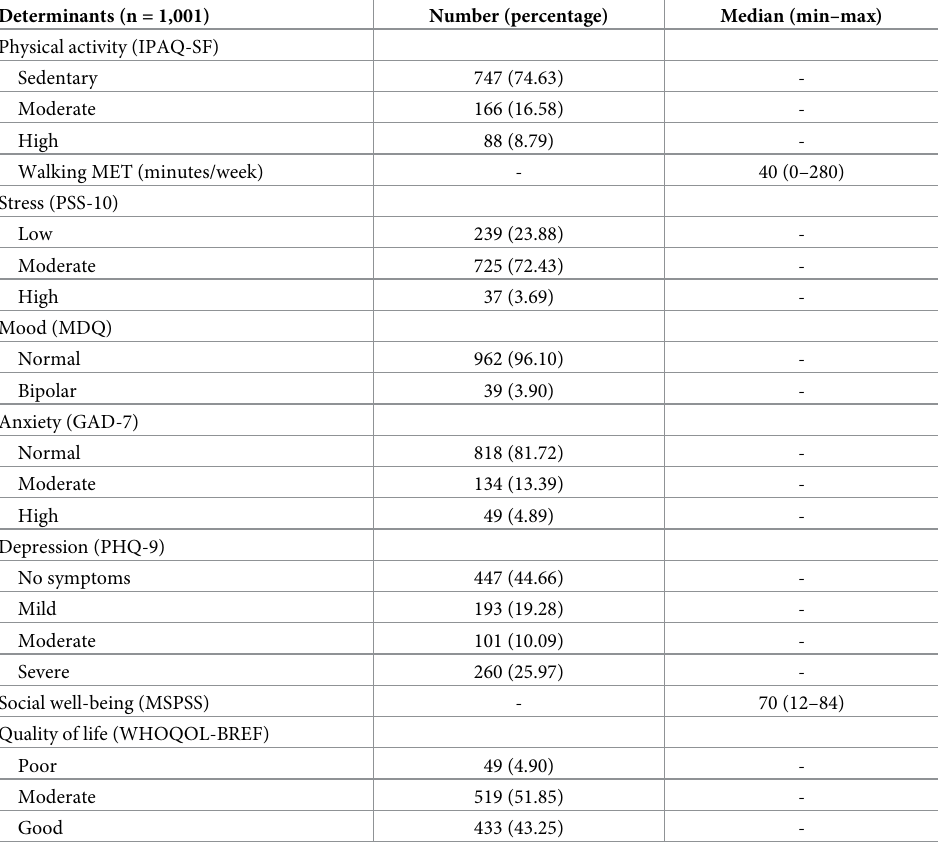
IPAQ-SF is International Physical Activity Questionnaire-Short Form, Walking MET is Walking Metabolic Equivalent, PSS-10 is Perceived Stress Scale, MDQ is Mood Disorder Questionnaire, GAD-7 is 7-item anxiety scale, PHQ-9 is Patient Health Questionnaire, MSPSS is Multidimensional Scale of Perceived Social Support, and WHOQOL-BREF is the World Health Organization Quality of